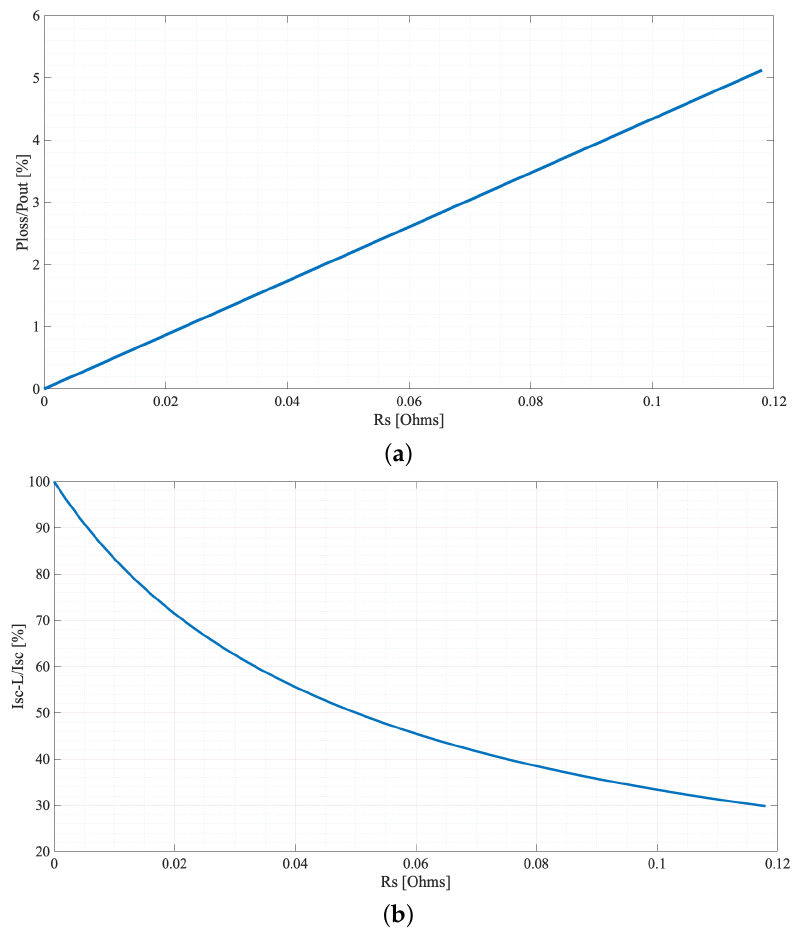
Figure 2. ( a ) The ratio of P loss to P out , and ( b ) the ratio of I SC − L to I SC as the functions of R S